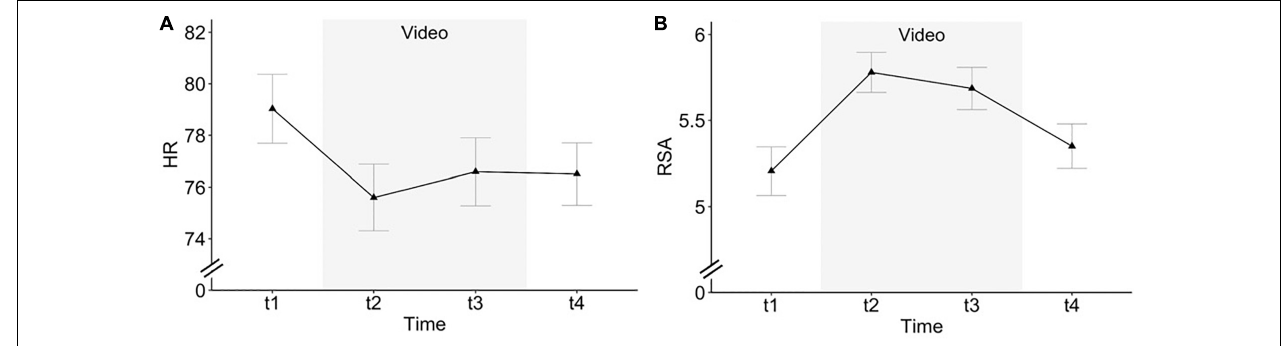
FIGURE 2 | (A) Heart rate (HR) and (B) respiratory sinus arrhythmia (RSA) over time in Study 1 (t1: first set of questionnaires, t2: first half of video, t3: second half of video, t4: second set of questionnaires); error bars depict standard errors of the mean.